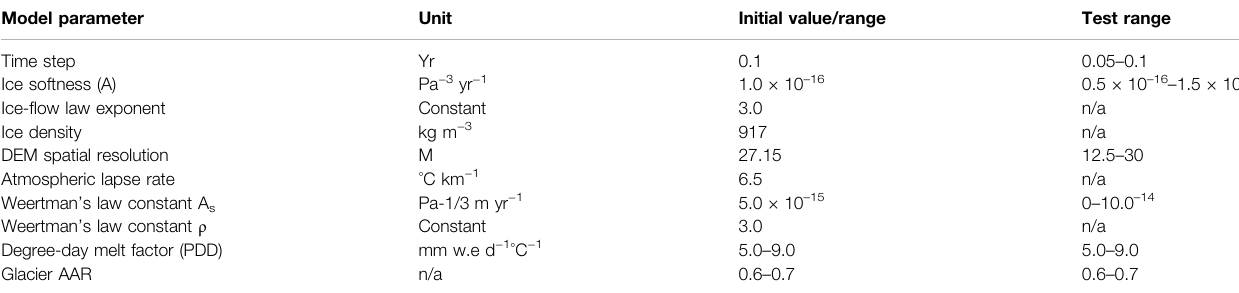
TABLE 2 | Coupled ice- fl ow and positive degree-day SMB model input parameters. Model